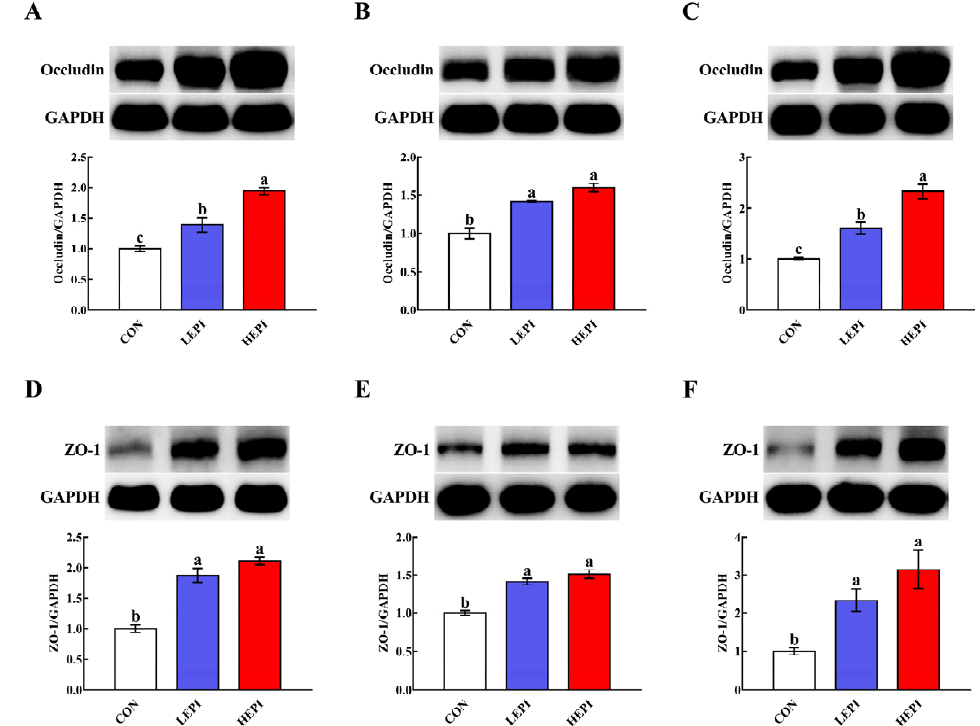
Figure 2. Effects of epicatechin on the abundance of intestinal tight junction proteins in mice. ( A − C ) Duodenal, jejunal, and ileal abundances of occludin, respectively. ( D – F ) Duodenal, jejunal, and ileal abundances of ZO-1, respectively. Data are expressed as means (eight mice/treatment), with standard errors represented by vertical bars. a–c Mean values with different superscripts indicate a significant difference ( p < 0.05). CON group: control group—mice received a standard diet; LEPI group—